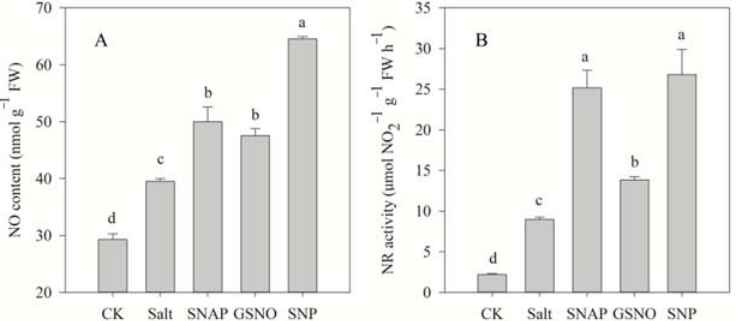
Figure 3. NO content ( A ) and nitrate reductase (NR) activity ( B ) of C. paliurus leaves under different treatments. CK (control, distilled water), salt (100 mM NaCl), SNAP (100 mM NaCl with 0.05 mM SNAP), GSNO (100 mM NaCl with 0.05 mM GSNO), SNP (100 mM NaCl with 0.05 mM SNP). Bars represent standard deviation (SD) of the means. Different letters suggest significant differences among the treatments at p < 0.05 (Duncan’s test).